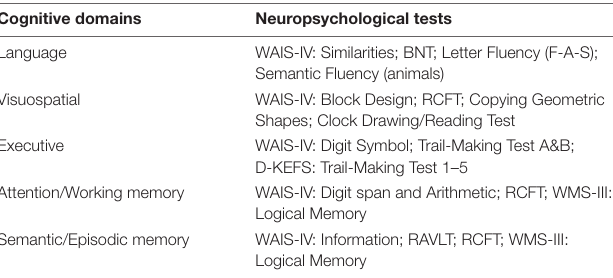
TABLE 1 | Cognitive tests used for subtyping of MCI patients into sd-aMCI and md-aMCI groups in the current study. Cognitive